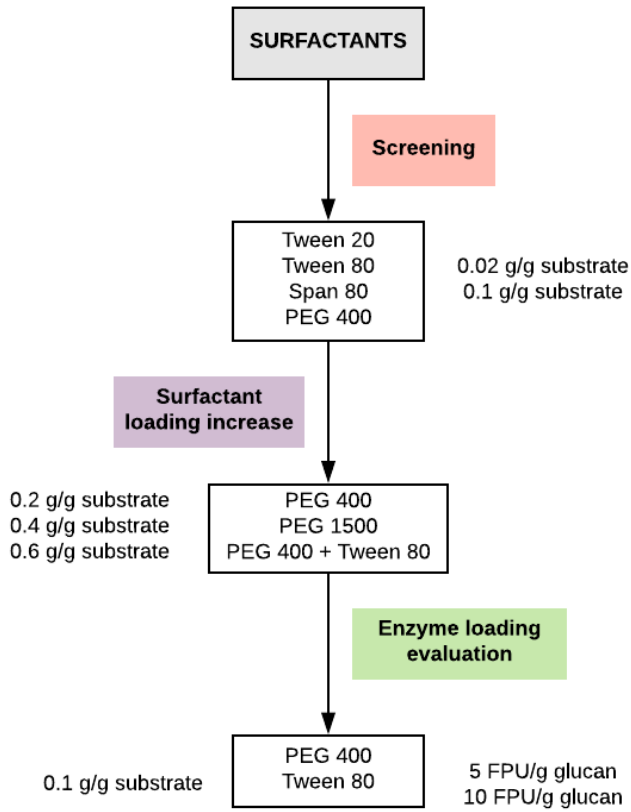
Figure 2. Methodology diagram for evaluation of surfactants’ effect on enzymatic hydrolysis.